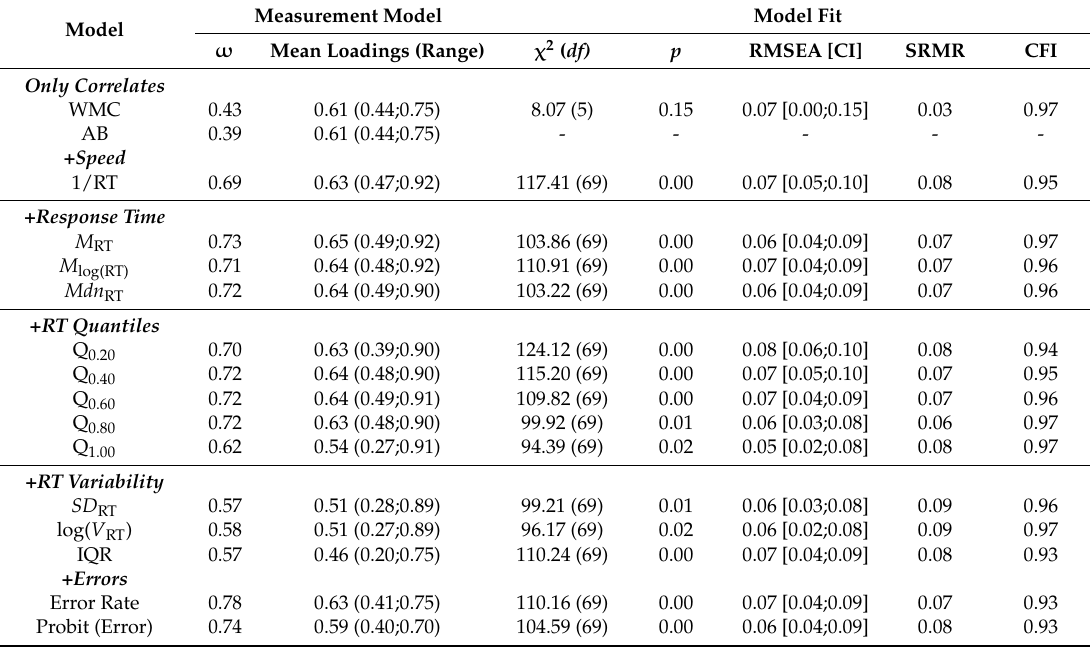
Table A1. Measurement models and model fits of mental speed general-factor models.